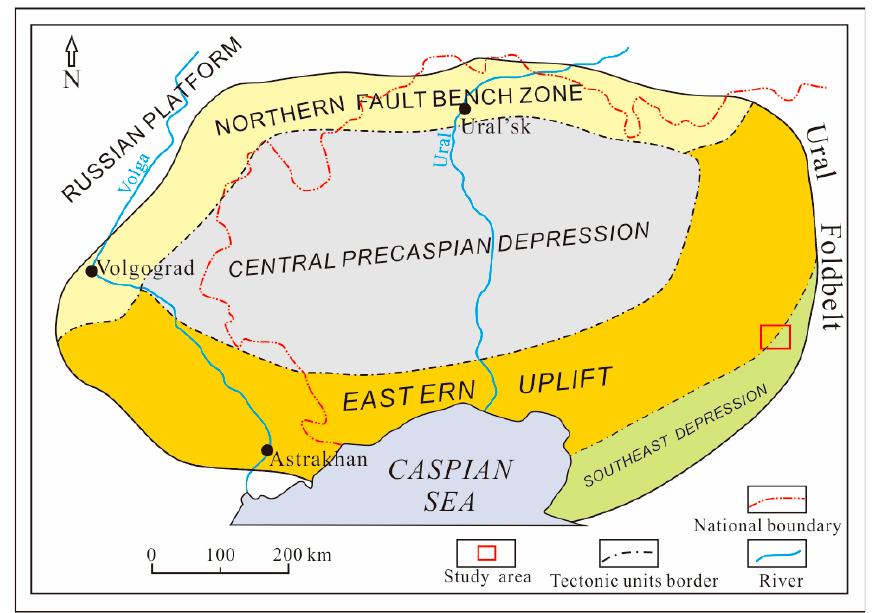
Figure 4. Tectonic settings and location of Central Block.